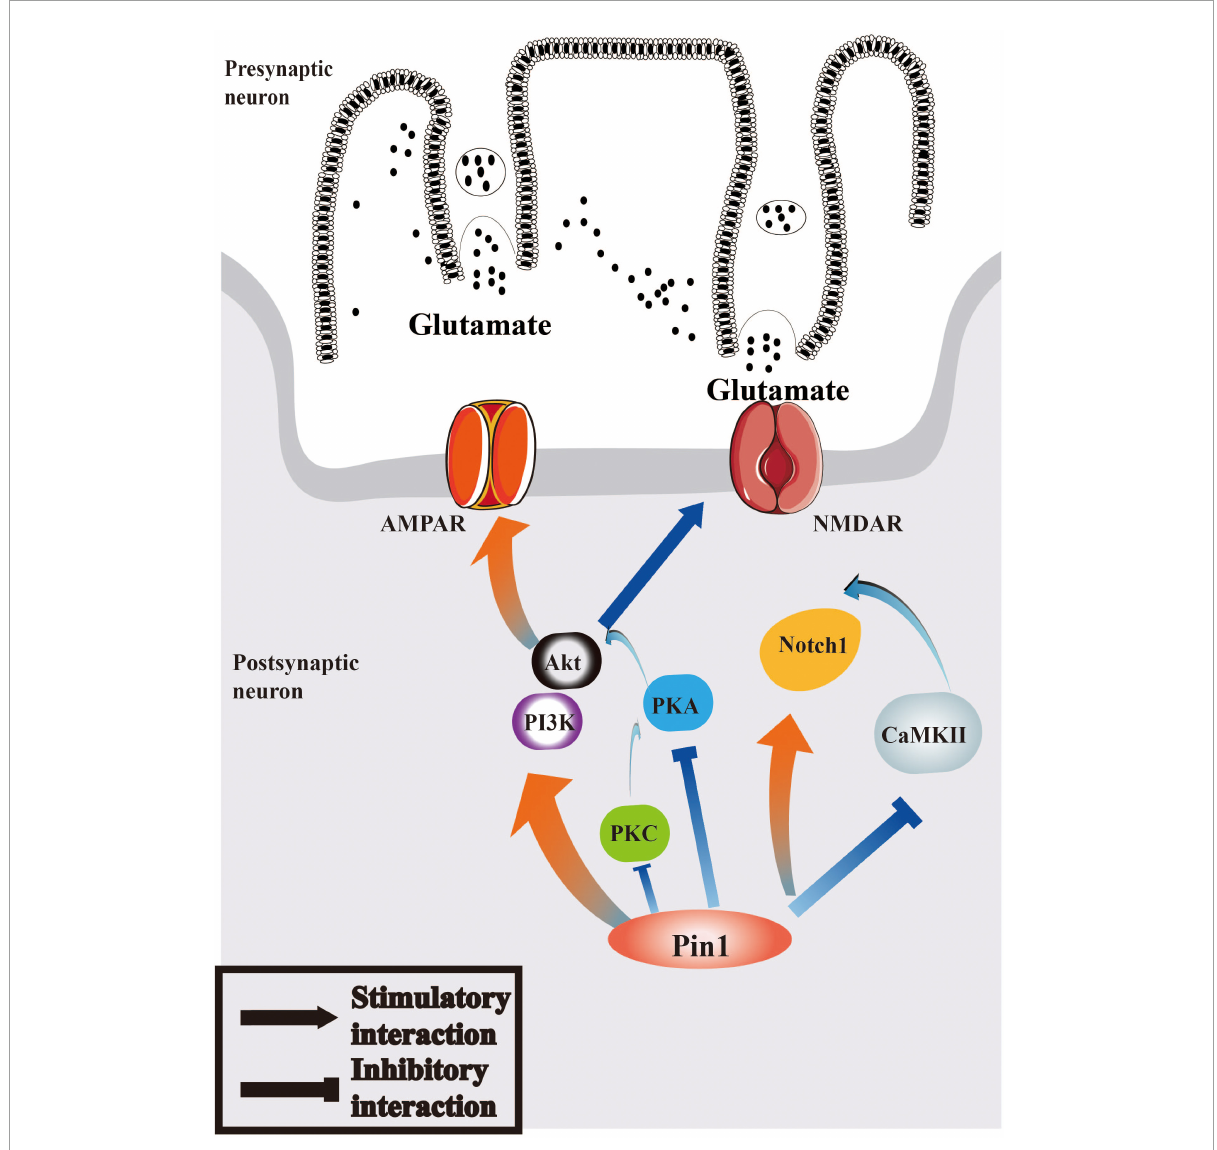
FIGURE2 Pin1 may regulate Notch1 signaling and PI3K/Akt signaling pathways in epilepsy. Pin1 has an interaction with Notch1 pathways, and the function may associated with CaMKII. AMPAR and NMDAR can both be mediated by PI3K/Akt pathway, whose activation will be regulated by PKA, PKC, and Pin1. The relationship between Pin1 and PKA, PKC and CaMKII deserved further